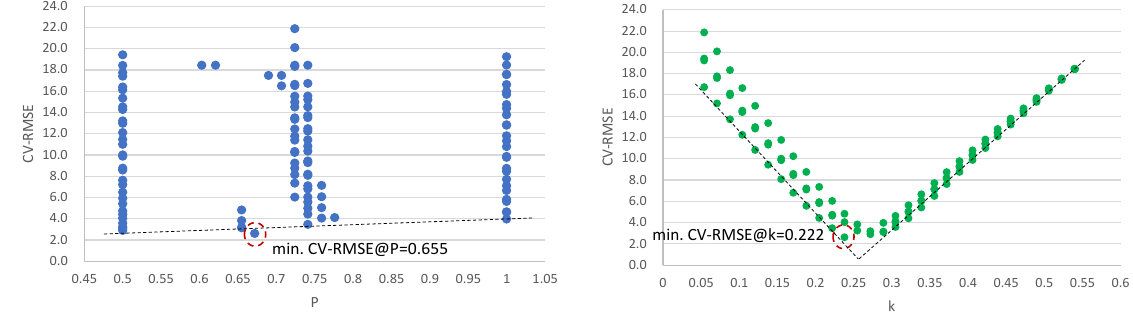
Figure 7. Influence profiles of P and k over the CV-RMSE for the PM2.5 decay scenario of Case I.